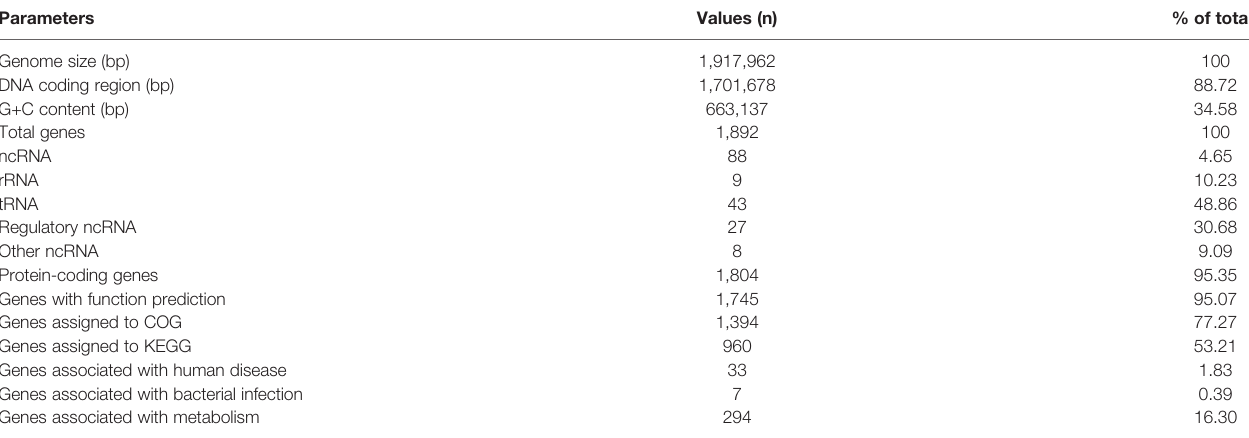
TABLE 2 | General features of the genome of P. septimus strain